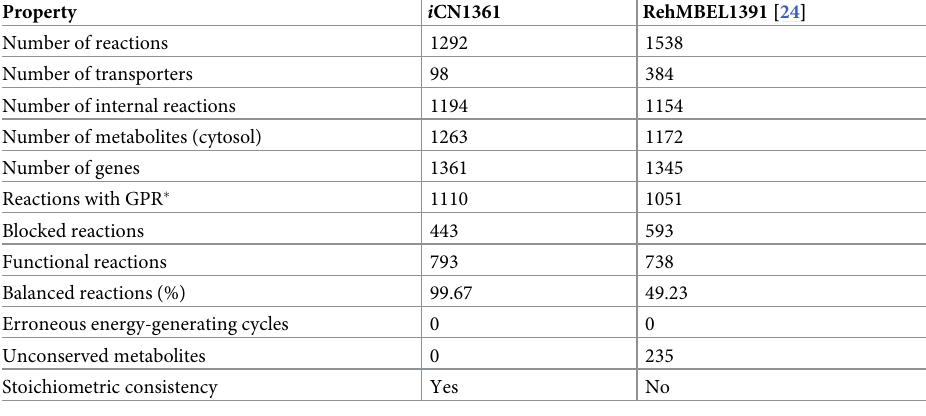
Table 1. Network property comparisons between i CN1361 and